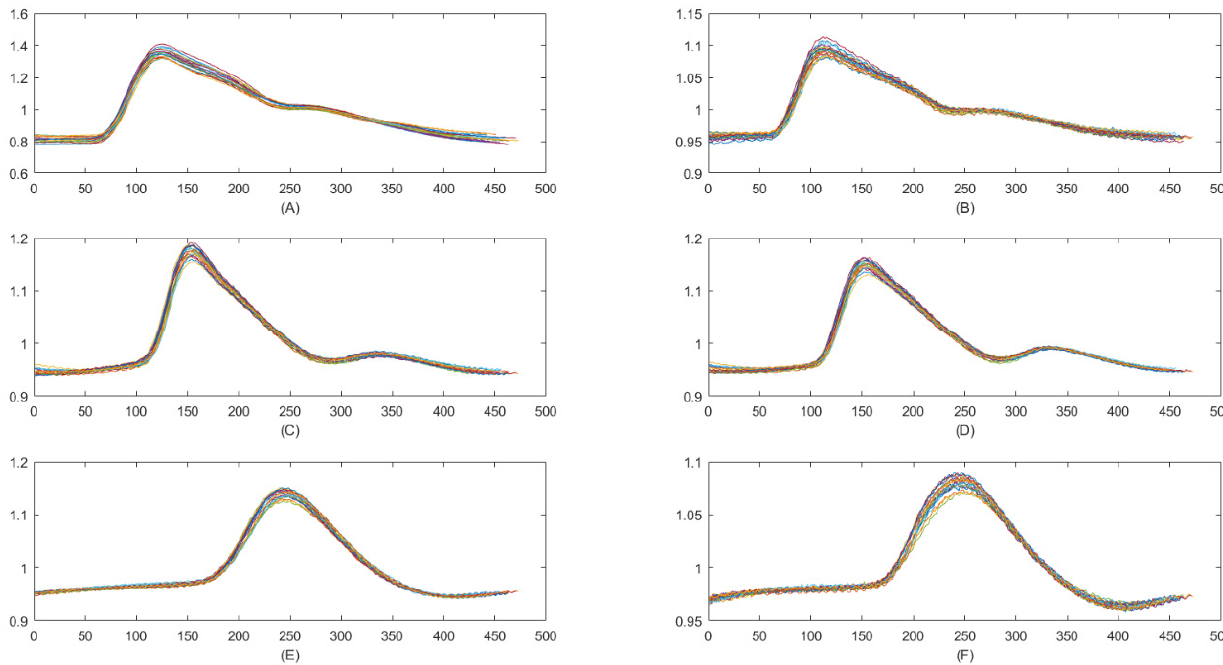
Figure 2. A total of 20 consecutive peripheral volume pulses measured from a six-channel electrocardiogram-based pulse wave velocity system (ECG-PWV) show different peripheral volume pulses from the ( A ) left ear lobe, ( B ) right ear lobe, ( C ) left index finger, ( D ) right index finger, ( E ) left second toe, and ( F ) right second toe, from one representative subject in Group 1.